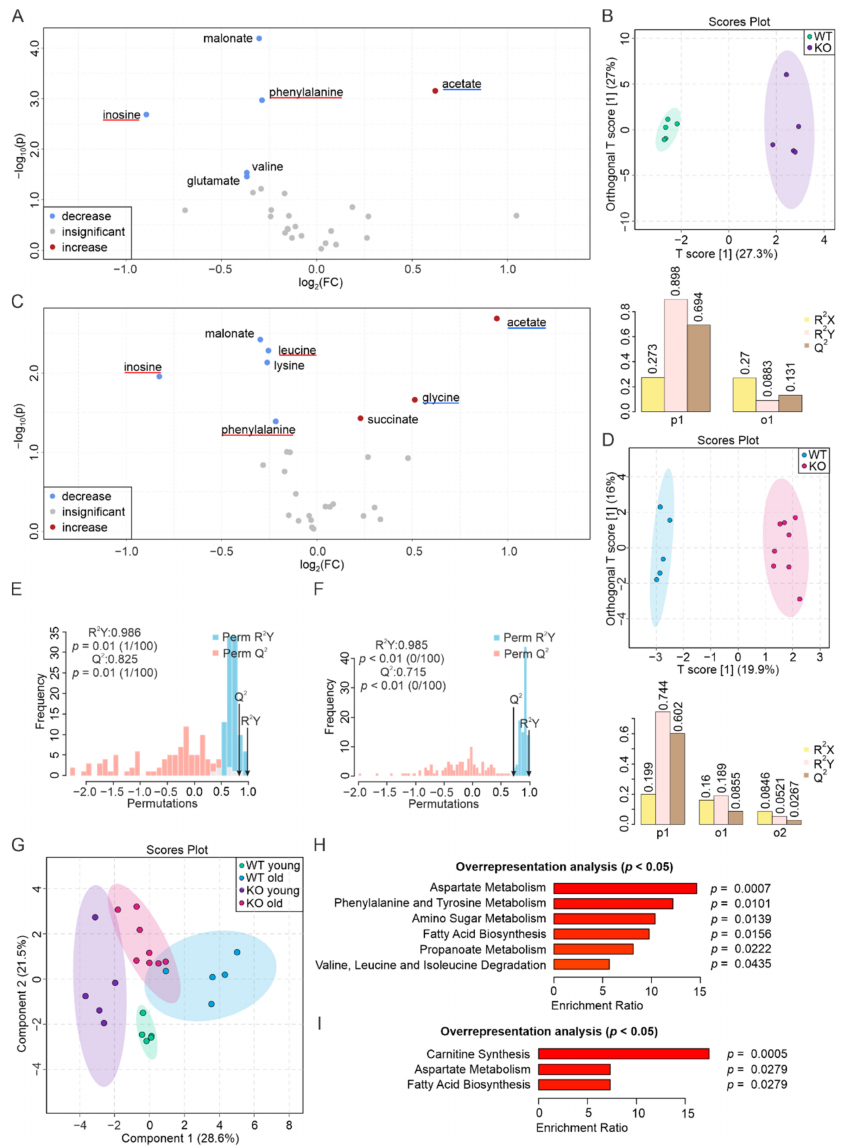
Figure 3. Contrasting metabolic changes in skeletal muscle upon PEMT deficiency and aging. ( A ) Volcano plot indicating increased (red), insignificantly changed (grey) and decreased (blue) metabolites in the PEMT KO skeletal muscle of young mice, in comparison to their WT coun- terparts. Underlines indicate aging biomarker(s) whose concentration(s) decrease(s) (blue) and increase(s) (red) in the WT aged skeletal muscle, as well as in ( C ). ( B ) O-PLS-DA plot clustering WT ( n = 5, green) and KO ( n = 5, purple) skeletal muscle samples from young mice (upper panel), along with the model quality assessment for p1 and o1 with cross-validation coefficients R 2 X, R 2 Y, and Q 2 (lower panel). ( C ) Volcano plot indicating increased (red), insignificantly changed (grey), and decreased (blue) metabolites in the PEMT KO skeletal muscle of aged mice, in comparison to their WT counterpart. ( D ) O-PLS-DA plot clustering WT ( n = 5, blue) and KO ( n = 8, pink) skeletal muscle samples from aged mice (upper panel), and model quality assessment for p1, o1, and o2 (second predictive component) with cross-validation coefficients R 2 X, R 2 Y, and Q 2 (lower panel). ( E ) Histogram showing the permutation test of samples in ( B ) and ( F ) samples in ( D ) with permuta- tion number n = 100, respectively. ( G ) S-PLS-DA plot of 4 skeletal muscle groups, with green, purple, blue, and pink corresponding to WT young, KO young, WT old, and KO old, respectively. ( H ) ORA of pathways associated with significantly changed metabolites in the skeletal muscle of young mice ( A ), and ( I ) of aged mice ( C ), with all pathways yielding p <